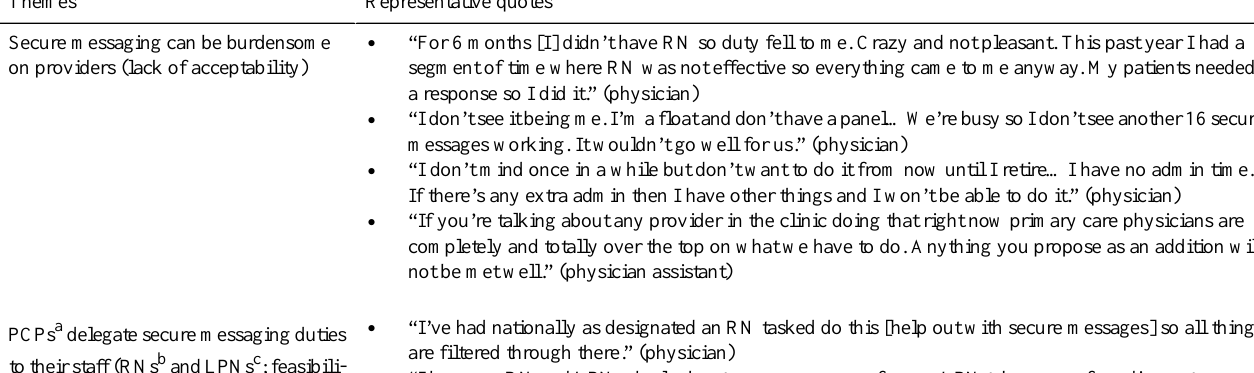
Table 3. Representative quotes from primary care providers.